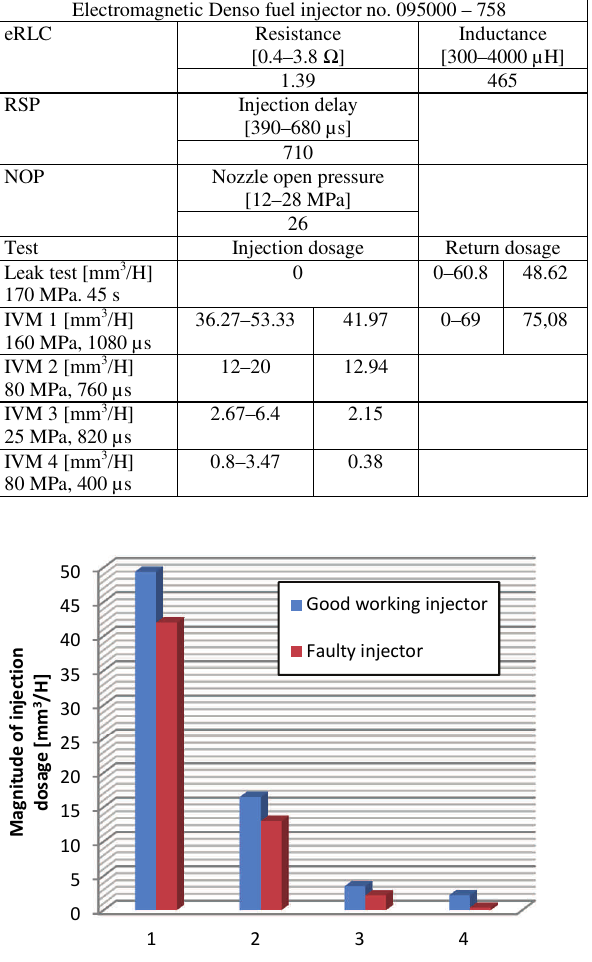
Table 6. Test results of faulty electromagnetic Denso fuel injector research